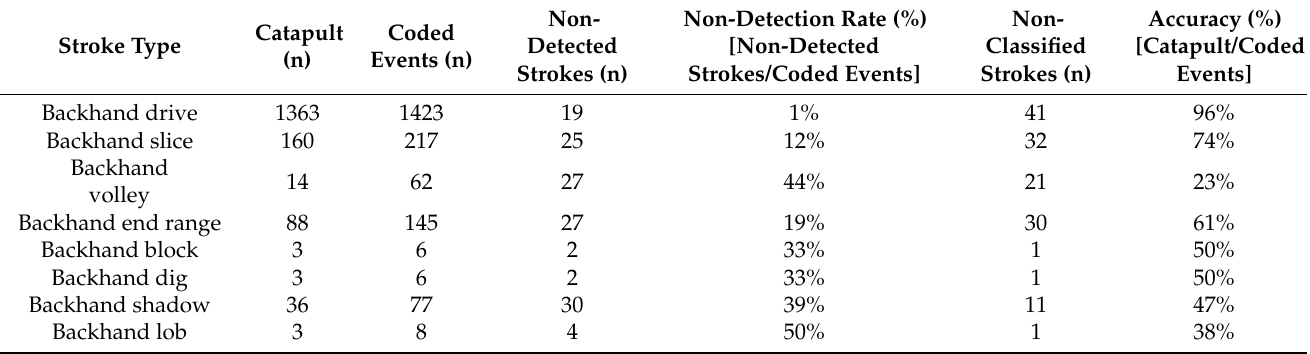
Table 4. Stroke-Level Analysis of Catapult Detected Backhand Strokes vs. Manual Coding Classifications.